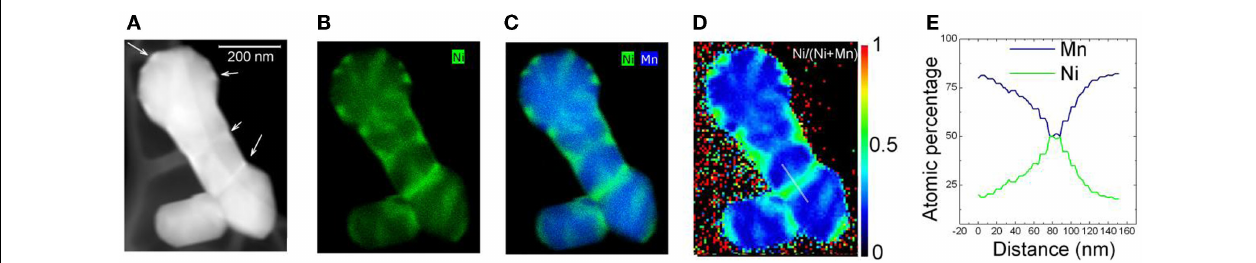
FIGURE 5 | Z -contrast image of multiple nanoparticle aggregation . (A) EDS maps. (B) Ni map. (C) Overlayed Ni and Mn map. (D) Ni/(Mn + Ni) atomic percentage quantification map. (E) Atomic percentage of Mn and Ni